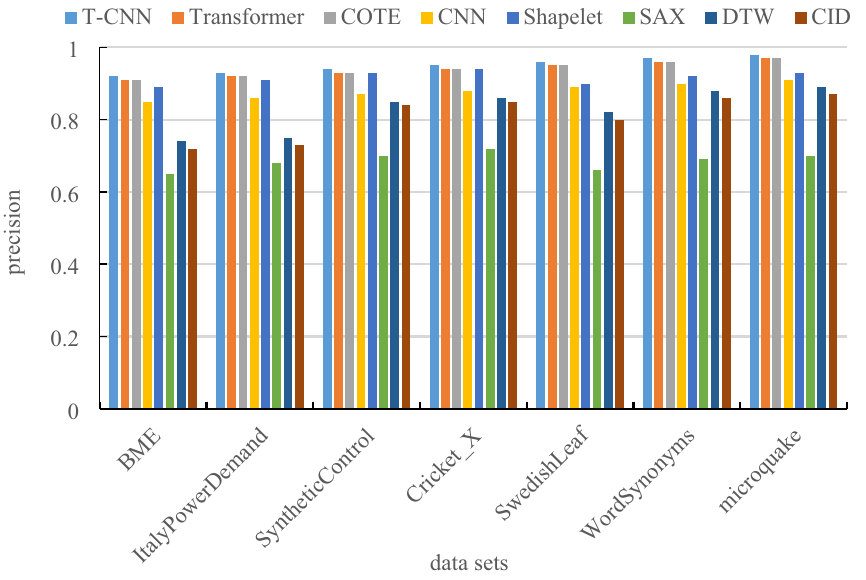
Figure 7. Comparison of classification precision.